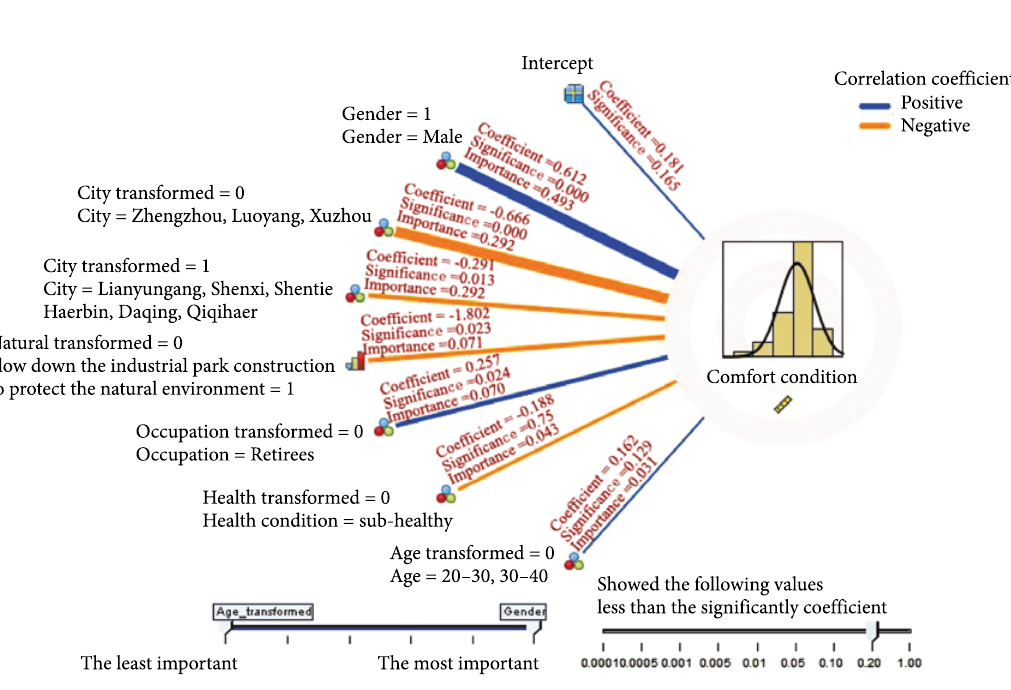
Fig. 7. The correlation between comfort levels and all other factors, based on automatic linear